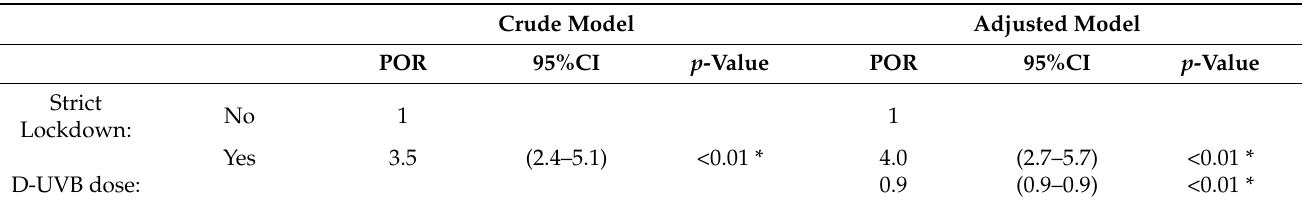
Table 2. Association study. Prevalence odds ratio for VDD, estimated by crude and adjusted logistic regression models. Crude Model Adjusted